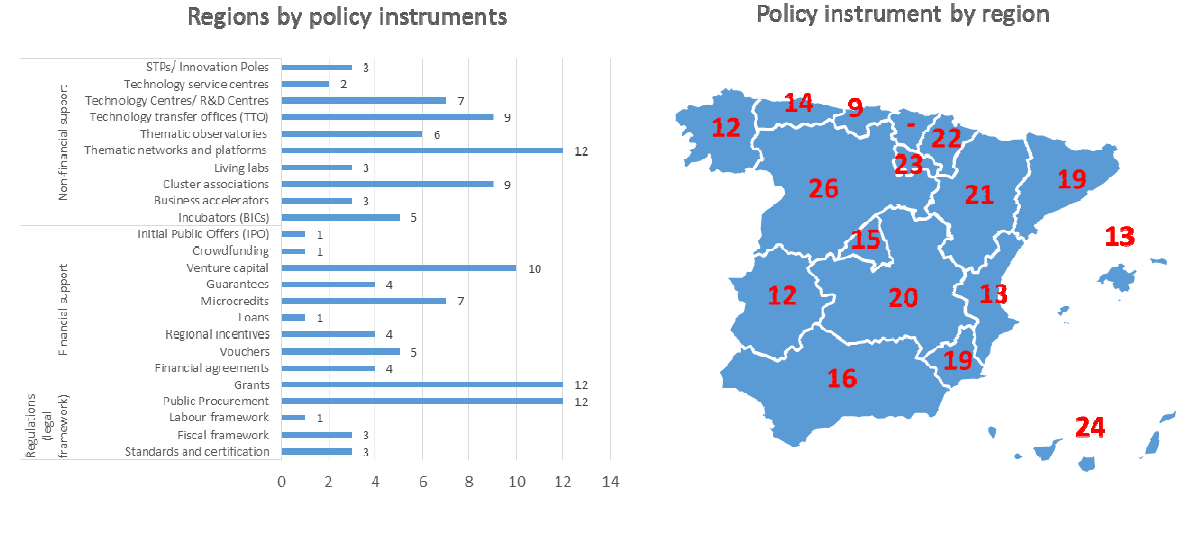
Figure 3: Regions in Spain by Type of Policy Instrument Included in the